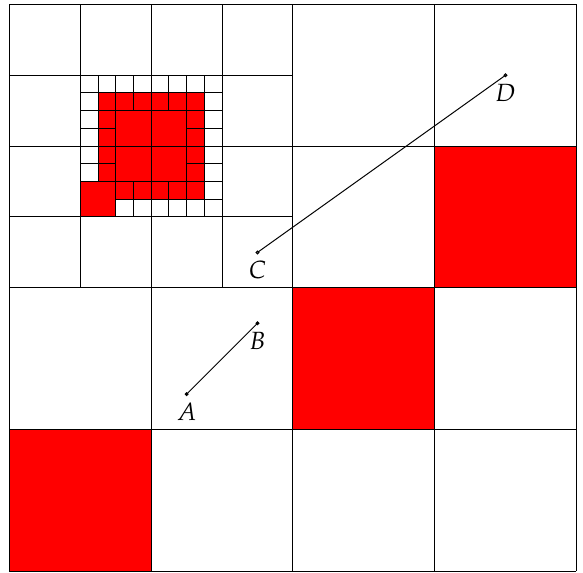
Figure 16. Free space checker example: in the case of the segment [AB], the octree cell is the same for A and B. However, for the segment [CD], the start cell is different from the end cell; therefore, a dichotomy is